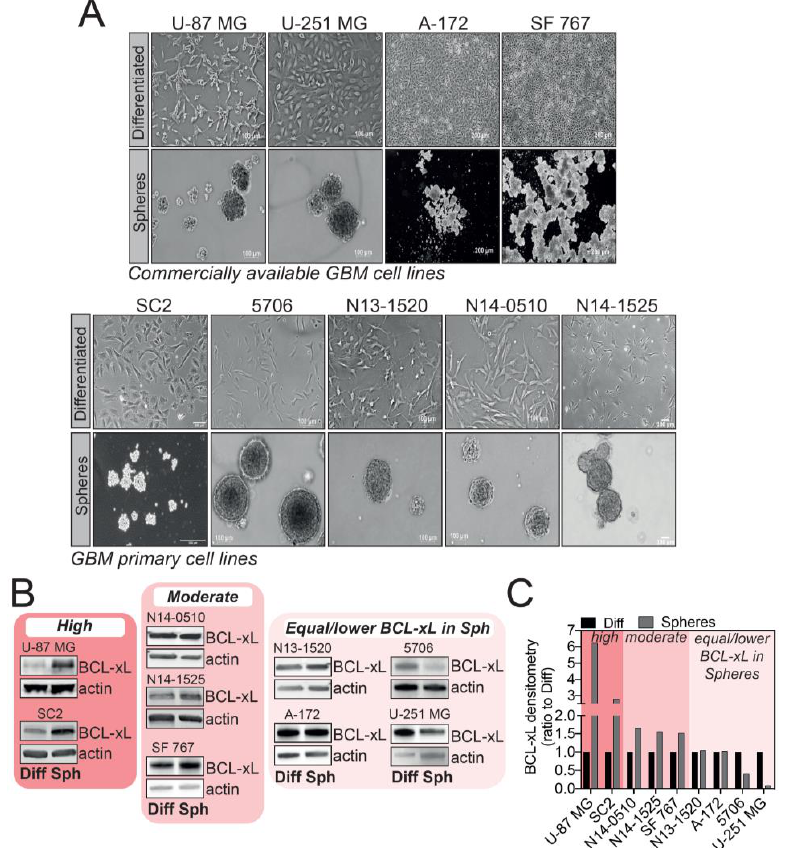
Figure 1. Evaluation of BCL-xL expression in tumorspheres versus differentiated cells in various commercially available and glioblastoma (GBM) patient-derived cell lines. ( A ) Images of GBM cell lines cultured as differentiated cells or tumorspheres. Magnification: 2.5X – 5X. ( B ) Western blot analysis